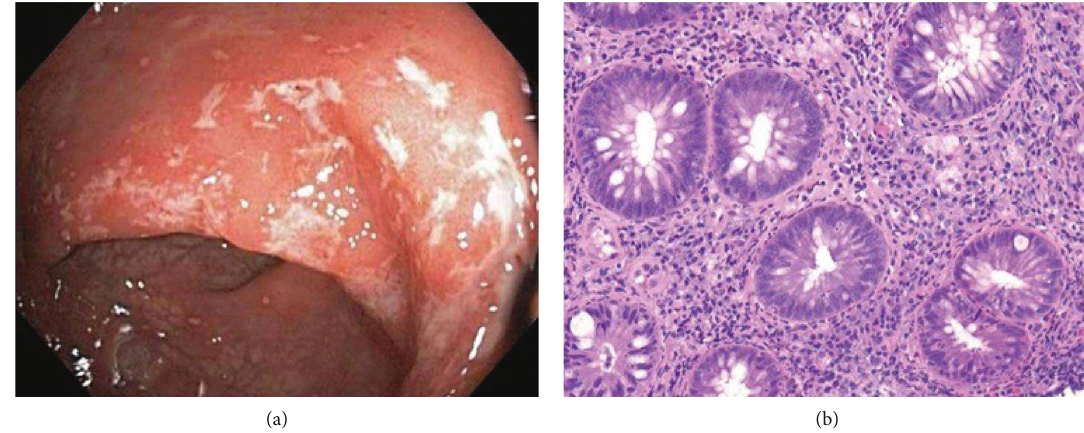
Figure 3: Endoscopic view of an HIV patient diagnosed with lymphogranuloma venereum (LGV) proctitis demonstrates moderate colitis in the rectum with erythematous and friable mucosa (a). Rectal biopsy specimen highlights moderately active proctitis with focal crypt distortion and cryptitis similar to CD (b). (Images obtained with permission from Gallegos et al.